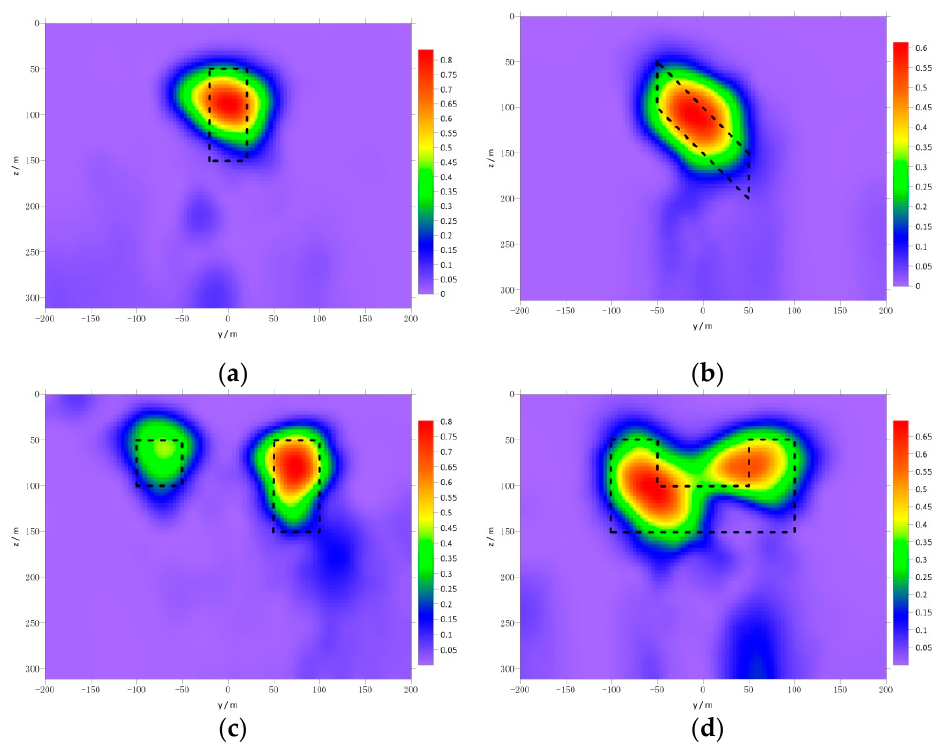
Figure 8. The inversion results of the model shown in Figure 2. ( a ) response of rectangular prism, ( b ) response of dipping prism, ( c ) response of parallel prism, ( d ) response of U prism.